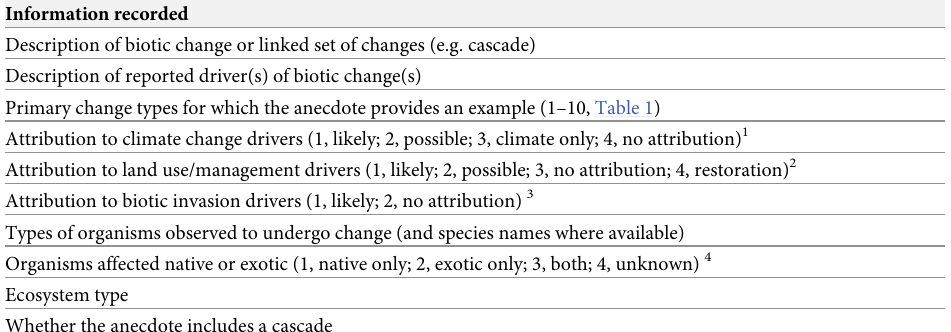
Table 2. Information recorded for systematic partitioning and scoring of anecdotal information from the survey. Information recorded Description of biotic change or linked set of changes (e.g. cascade) Description of reported driver(s) of biotic